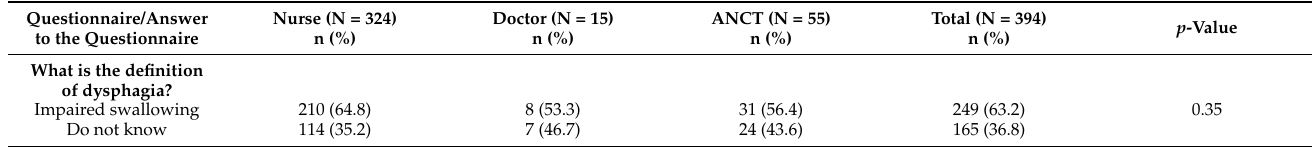
Table 2. Health professionals’knowledge and management of patients with liquid